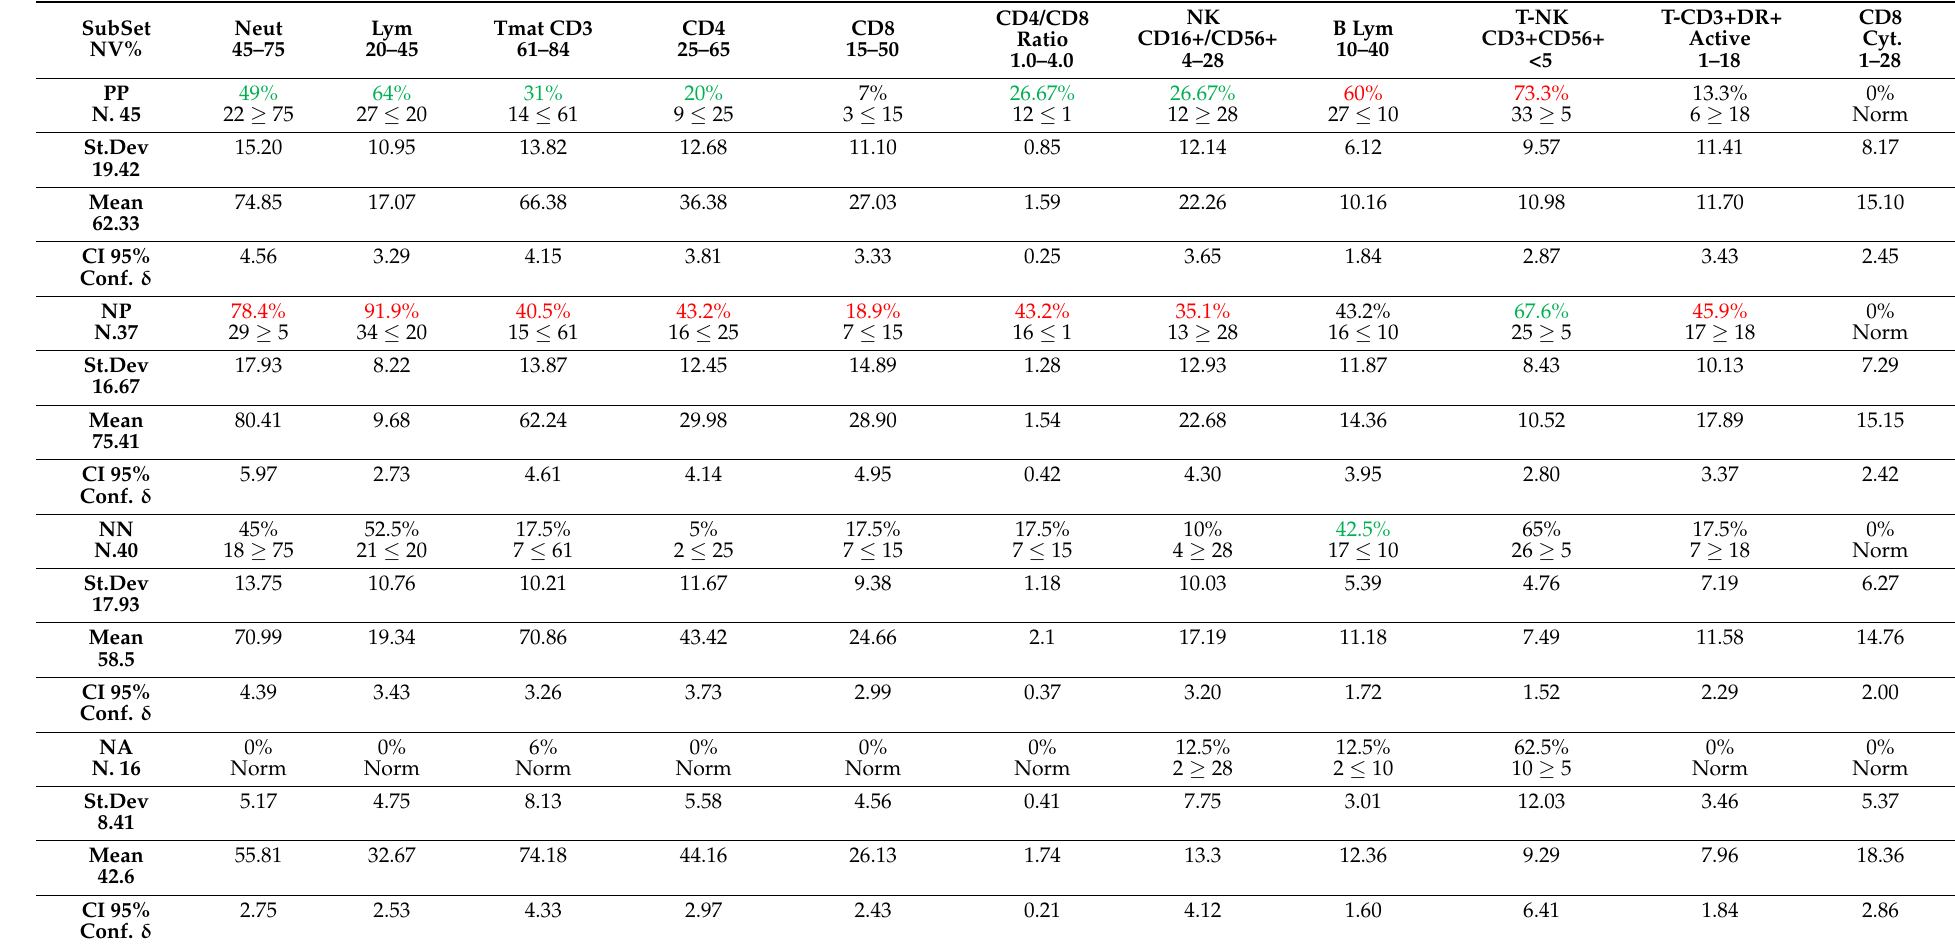
Table 1. Flow-cytometry summary and statistical profile of four groups included in this study (CI 95%, conf. δ ). The frequency of T cell subsets and B-lymphocytes were analyzed from blood collected in COVID-19 patients (PP); NP (negative swab-CT ground glass); NN (patients with different lung pathologies); NA (healthy individuals). NV% = normal value (%); St.Dev = standard deviation; Conf. δ = confidence delta. The red color indicates the worst level and the green the second worst; Norm: